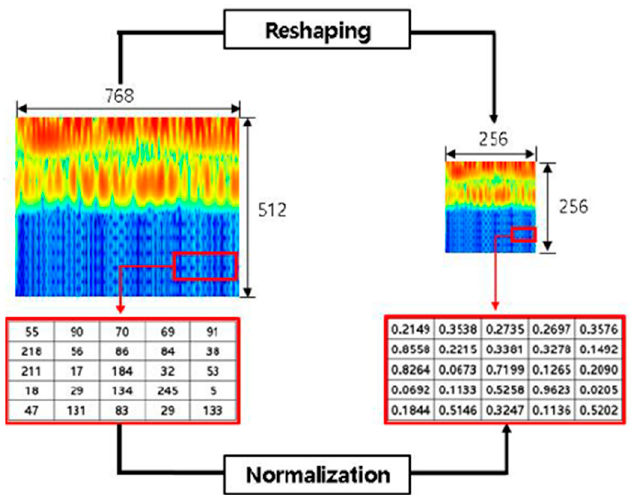
Figure 5. Size conversion and normalization of spectral images.